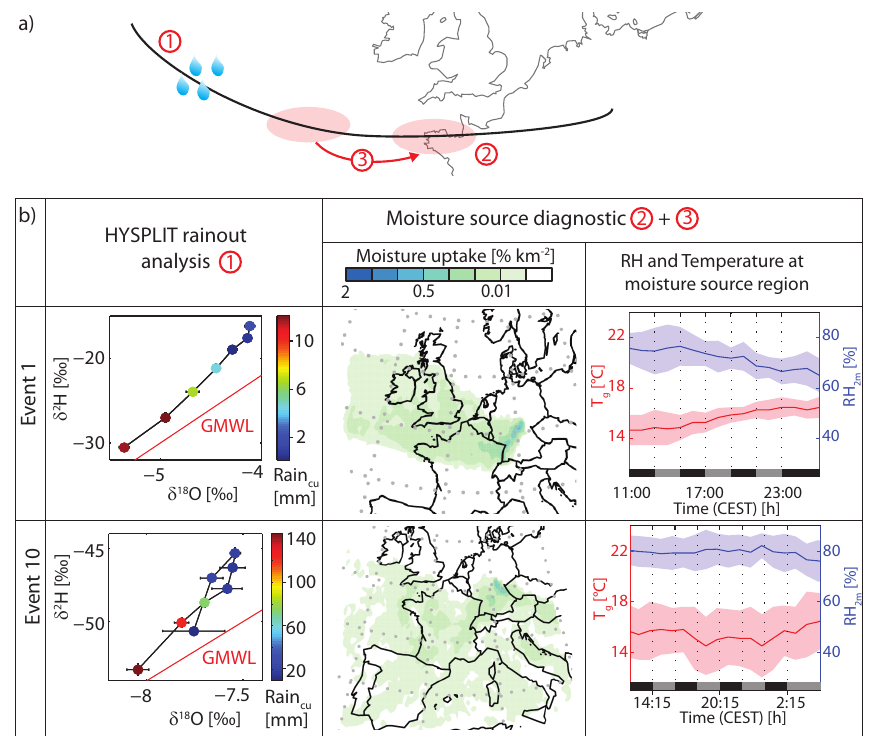
Fig. 6. Panel (a) : Suggested effects causing the δ c variation during cloud events 1 and 10: 1 (cid:13) rain out along the trajectory, 2 (cid:13) meteorological changes in the source moisture region or 3 (cid:13) change of source moisture region. Panel (b) : Illustration of mechanism 1 (cid:13) , 2 (cid:13) and 3 (cid:13) for event 1 and 10. First column: cumulative rain along the HYSPLIT single trajectory for every measurement point as described in Sect. 2.3. Second column: geographical visualization of the moisture source region, deduced by the moisture source diagnostics (Sect. 2.3). Third column: temporal evolution of the relative humidity (blue) and temperature (red) at the moisture source region for the cloud sampling intervals indicated in black and